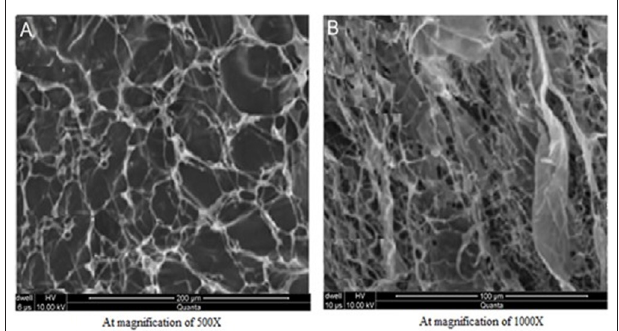
FIGURE 4 | SEM images of ACV loaded hydrogel (A) At 200 µ m (B) At 100 µ